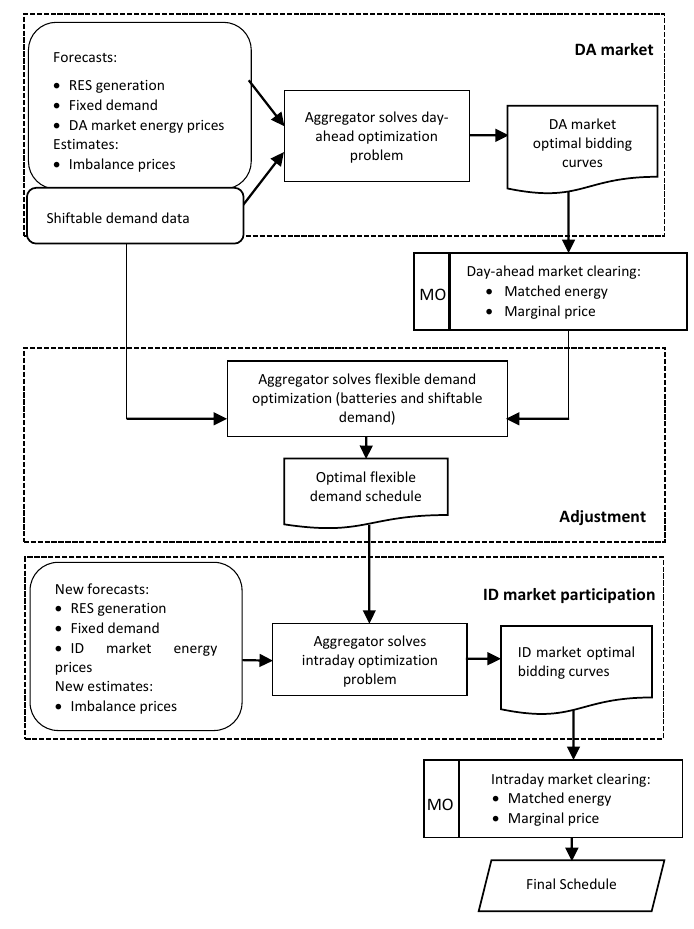
Figure 1. Aggregator participation in the day-ahead and intraday markets.